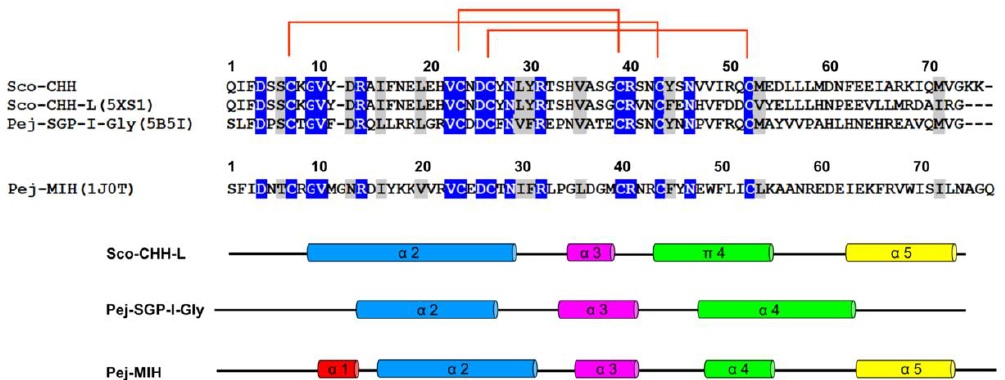
Figure 3. Sequence alignment and secondary structure of four CHH/ITP peptides. Sequence alignment and secondary structure of four CHH-superfamily peptides. Amino acid sequences of the mature peptide of three Type-I peptides, Sco- CHH, Sco-CHH-L, and Pej-SGP-I-Gly, and that of a Type-II peptide, Pej-MIH, are aligned. Accession number for the amino acid sequence is, respectively AY372181, EF530127, AB007507, and P55847. For Sco-CHH-L, Pej-SGP-I-Gly, and Pej-MIH, location of the secondary structures is given. The conserved pattern of disulfide bridge connectivity (Cys 7 –Cys 43/44 , Cys 23/24 – Cys 39/40 , and Cys 26/27 –Cys 52/53 ) is indicated by orange lines.